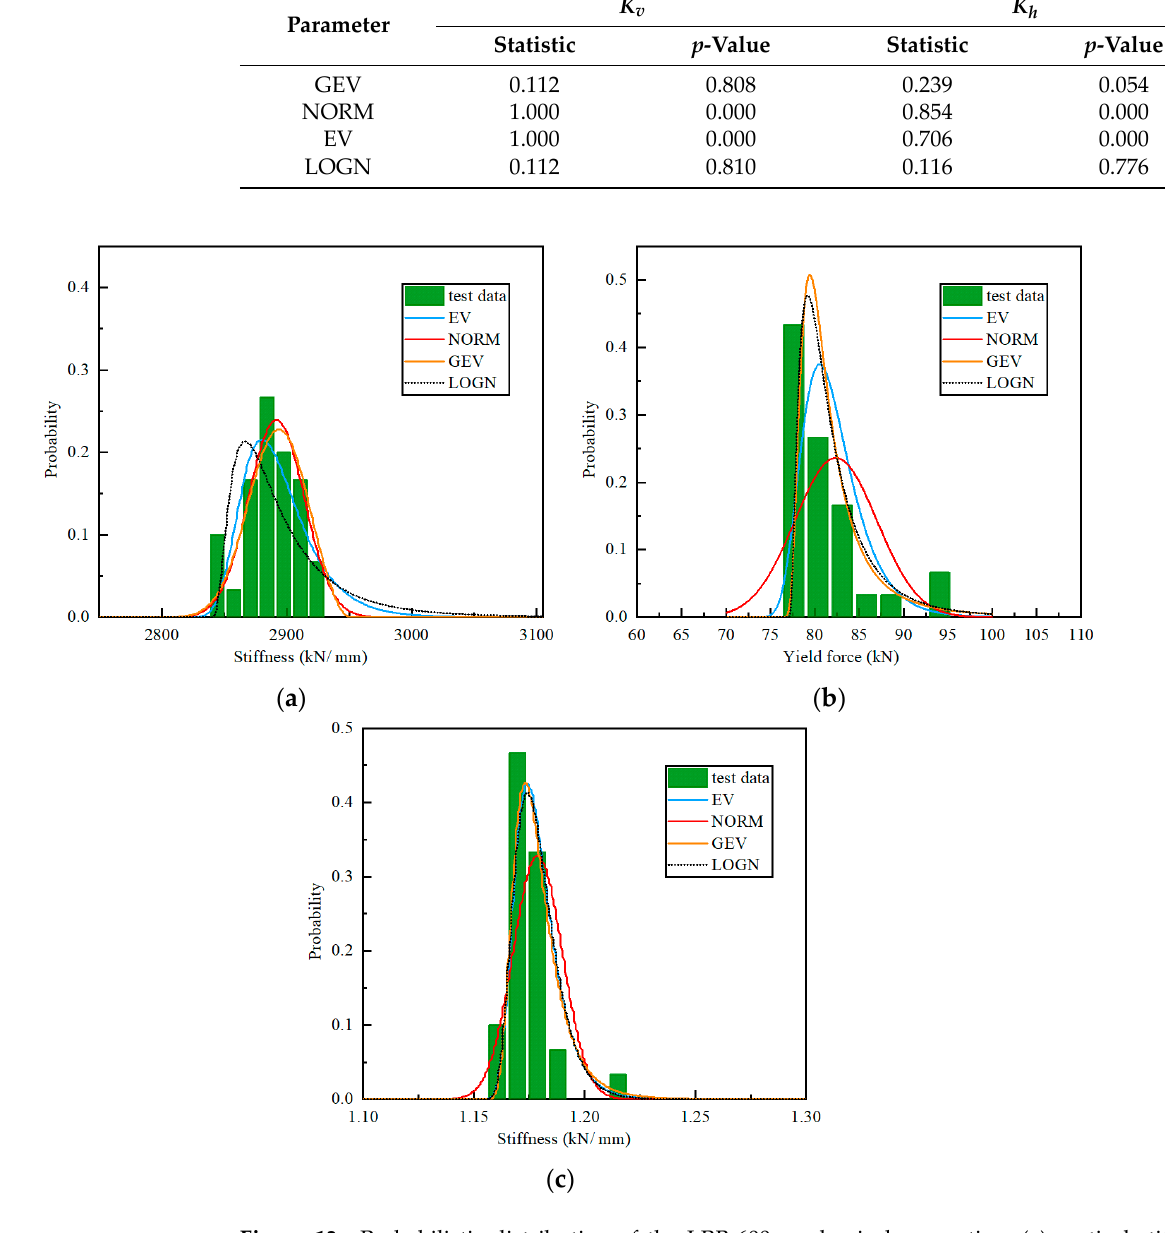
Figure 13. Probabilistic distribution of the LRB‑600 mechanical properties: ( a ) vertical stiffness; ( b ) yield force; ( c ) post‑yield stiffness. Table 8. Statistic and p ‑value in the Kolmogorov‑Smirnov test of the LRB